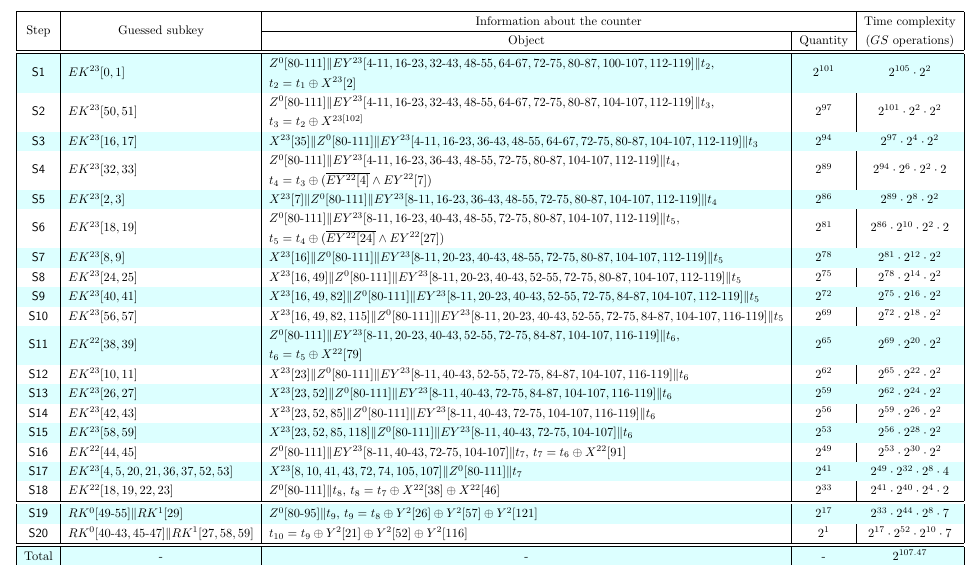
Table 2: Detailed computation of